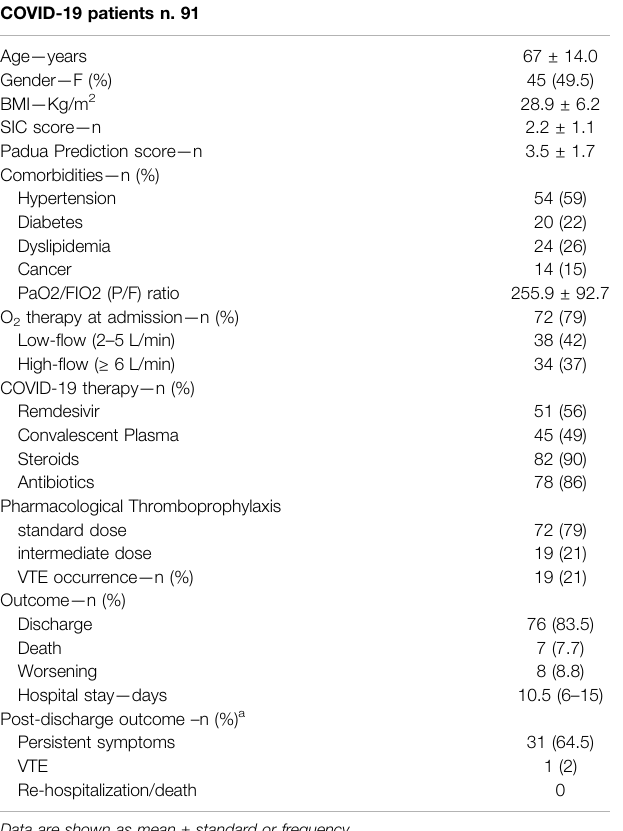
TABLE 3 | EVs levels COVID-19 patients and healthy controls. EVs subgroup COVID-19 Healthy baseline (n. 91) controls (n.